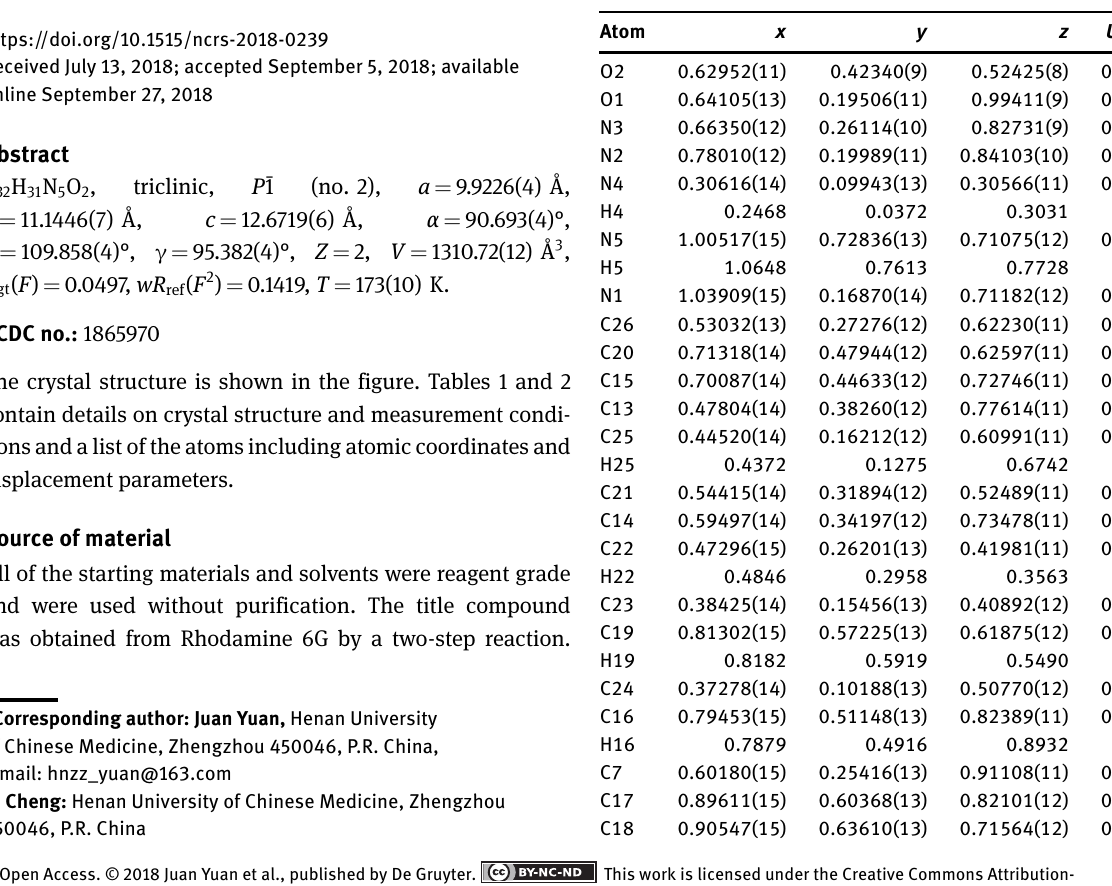
Table 2: Fractional atomic coordinates and isotropic or equivalent isotropic displacement parameters (Å 2